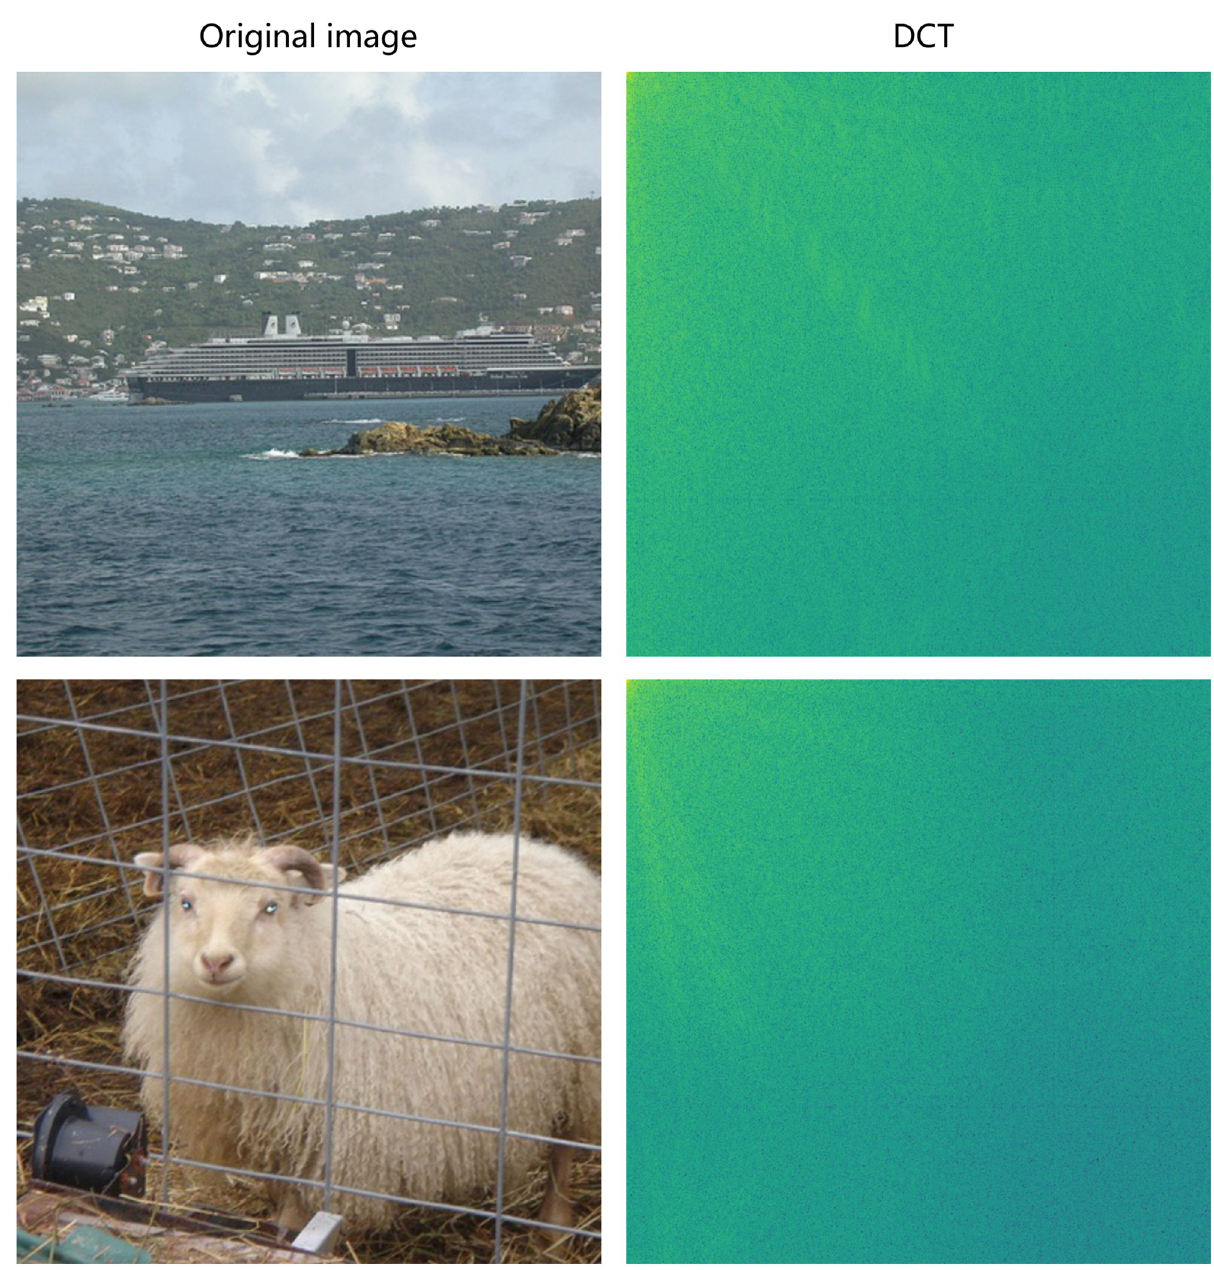
Fig 3. Example of DCT